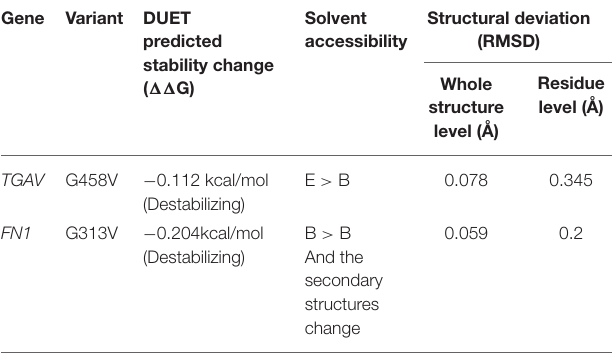
TABLE 3 | DUET program protein stability prediction of ITGAV and FN1 variants. Gene Variant DUET